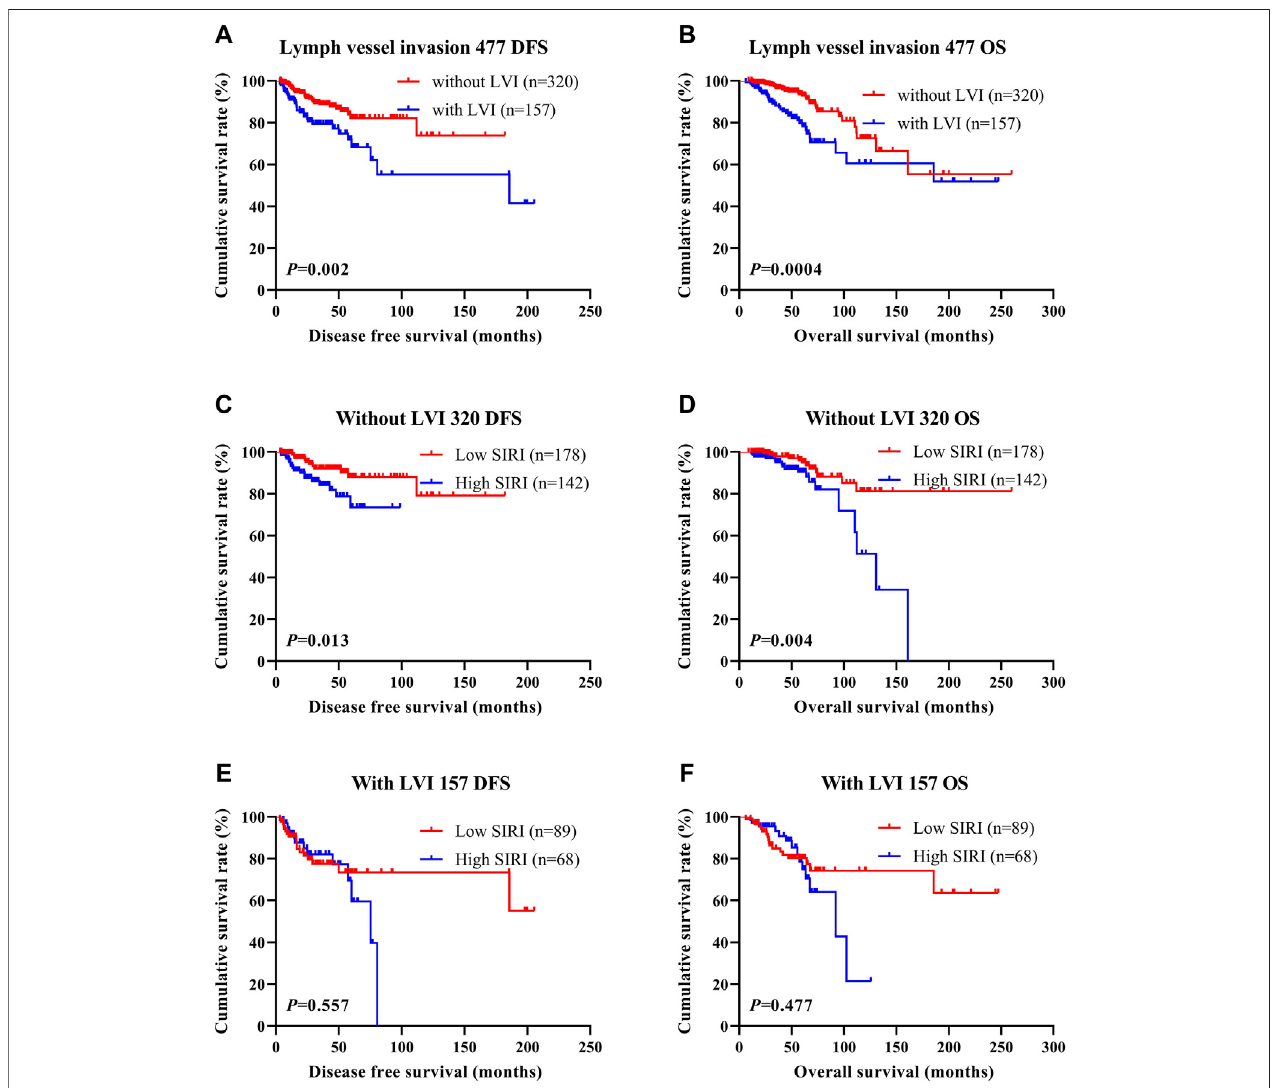
FIGURE 7 | DFS and OS based on the presence of lymph vessel invasion in breast cancer patients (NACT group). DFS and OS based on the presence of lymph vesselinvasioninbreastcancerpatients(NACTgroup). (A) Kaplan-MeieranalysisofDFSfortheSIRIofallpatientswithbreastcancer. (B) Kaplan-MeieranalysisofOSfor theSIRIofallpatientswithbreastcancer. (C) Kaplan-MeieranalysisofDFSfortheSIRIofbreastcancerpatientswithoutlymphvesselinvasion. (D) Kaplan-Meieranalysis ofOSforthe SIRI ofbreast cancer patients without lymphvesselinvasion. (E) Kaplan-Meier analysisofDFS for theSIRI ofbreastcancer patients withlymphvessel invasion. (F) Kaplan-Meier analysis of OS for the SIRI of breast cancer patients with lymph vessel